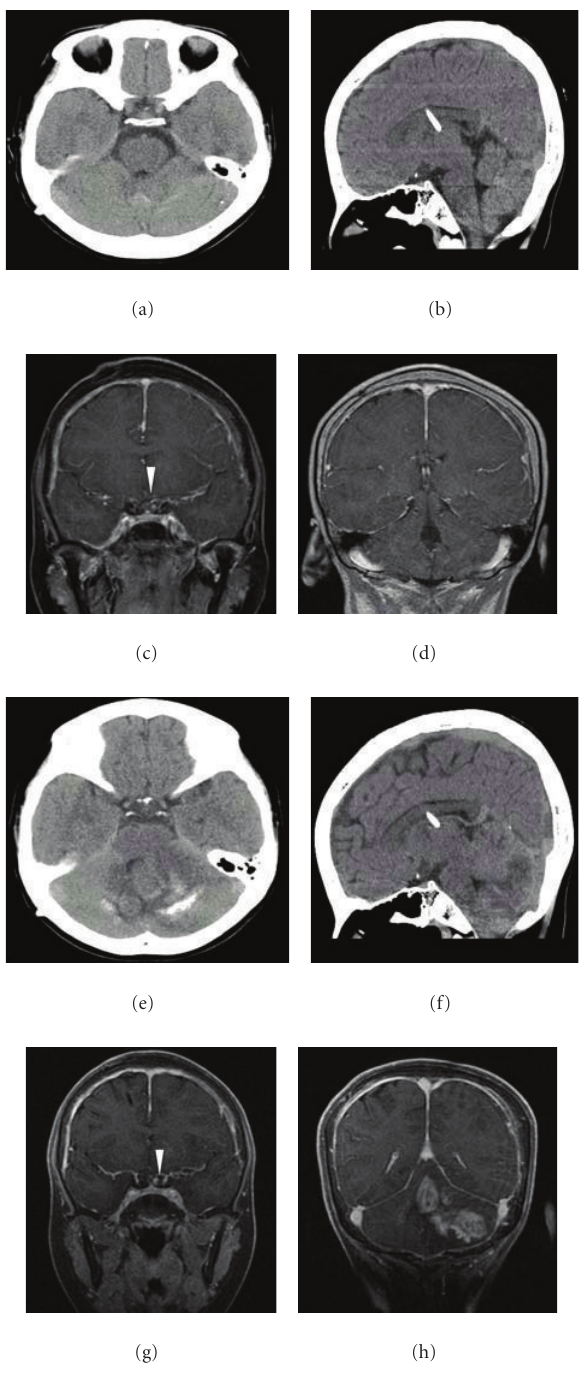
Figure 1: Neuroimaging findings of sGBM. Axial noncontrast CT shows stable changes of mineralization of the posterior fossa without hydrocephalus 3 weeks before tumor recurrence (a) and (b). Postgadolinium coronal MRI (c) shows stable suprasellar disease at baseline (arrow) and no evidence of cerebellar mass 3 months prior to relapse (d). Axial and coronal noncontrast CT at relapse 3 weeks following initial CT shows a large cerebellar tumor with extensive edema and compression of the 4th ventricle (e) and (f). Postgadolinium MRI confirms the CT findings with a stable suprasellar mass (g) compared to baseline and a new large posterior fossa cerebellar tumor